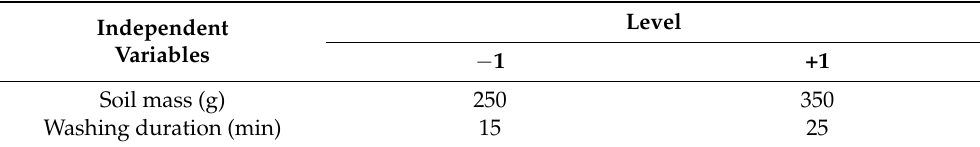
Table 4. Independent variables and levels considered in the 2 2 full factorial design. Decoded values.